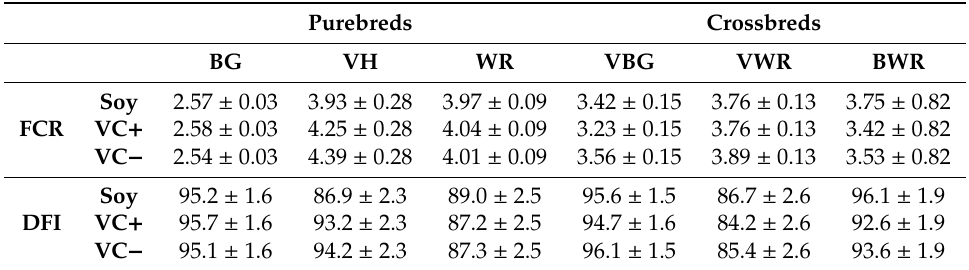
Table 4. Least square means ( ± SE) for the e ff ect of feeding treatment on feed conversion ratio (FCR, in kg / kg) and daily feed intake (DFI, in